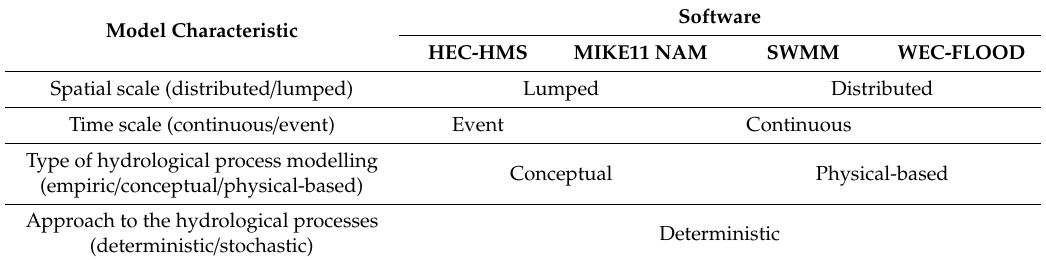
Table 1. Main characteristics of the software applied to the Mesima torrent (Calabria, Southern